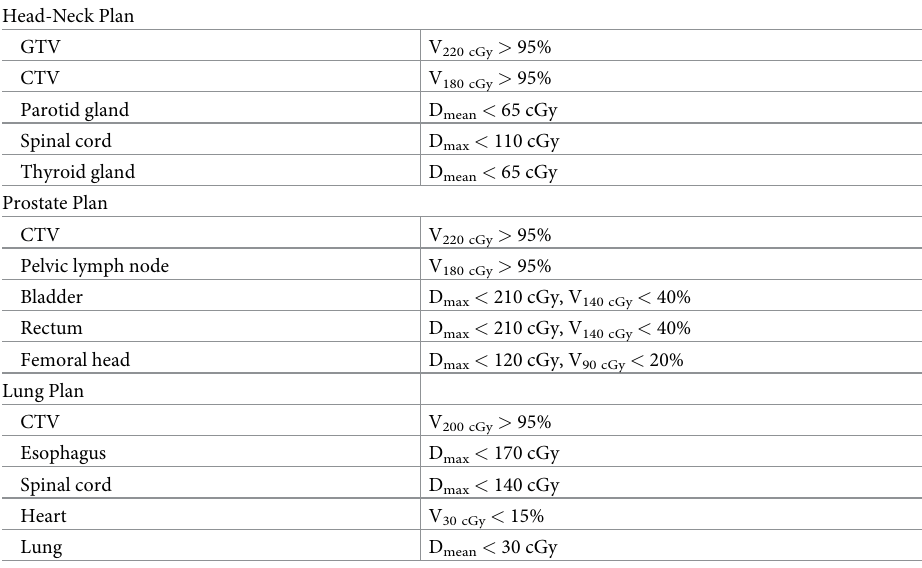
Table 1. Dose constraints used for the IMRT and rapidArc